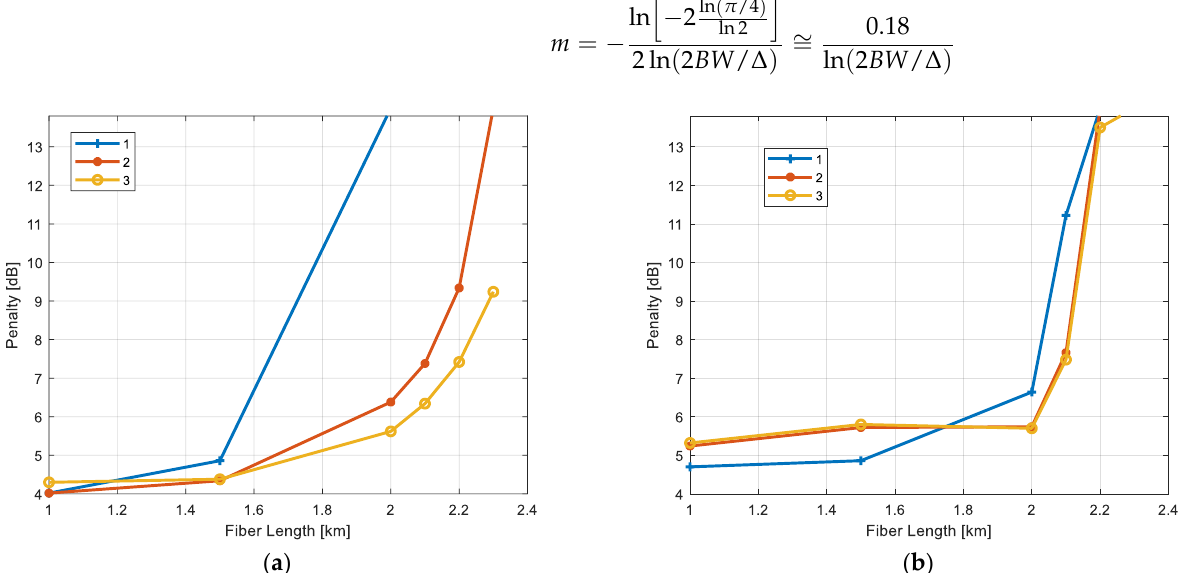
Figure 12. Penalty vs. fiber length (km) of PAM-8 with SG filter orders of 1, 2, and 3 (in legend) with 3 dB BW at ( a ) 40 GHz and ( b ) 80 GHz.